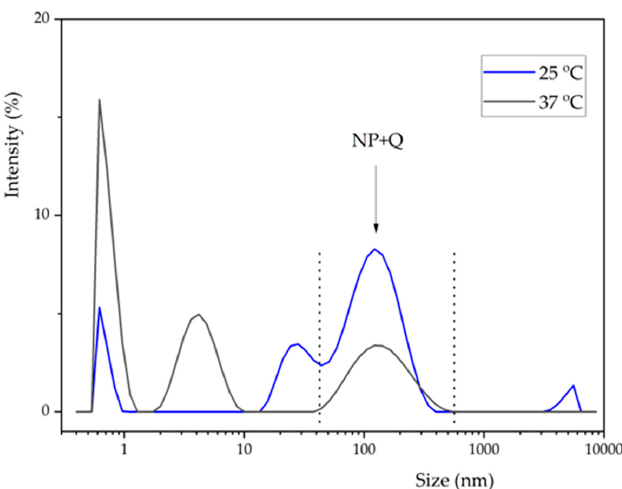
Figure 3. Quercetin loaded nanoparticles (NP+Q) size distribution obtained in water by DLS analysis at 25 and at 37 °C. Table 1. DLS Data of the quercetin loaded nanoparticles (NP+Q).